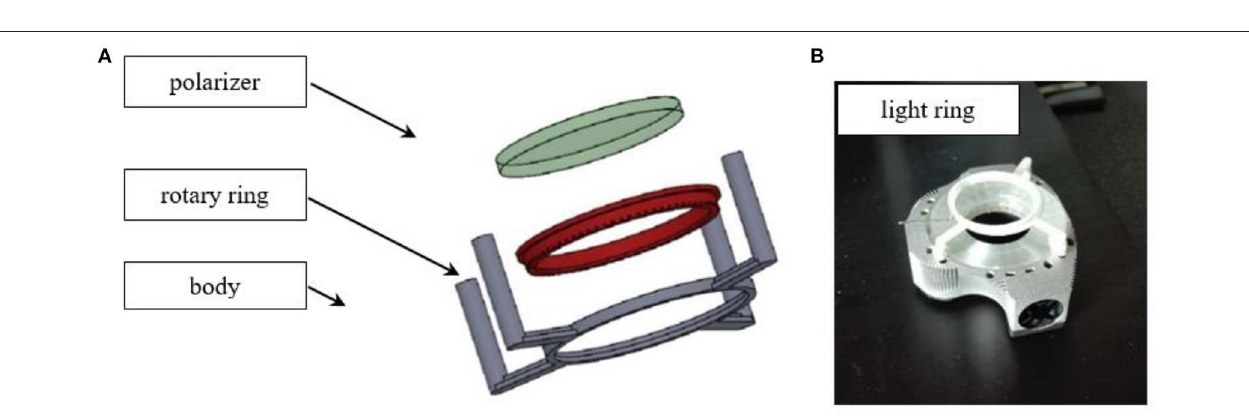
FIGURE 6 | External polarizer placed in front of the lens of the ALICONA profilometer for usage with light ring: (A) the view of the external polarizer fixing and (B) the actual assembly of the polarizer on the light ring.